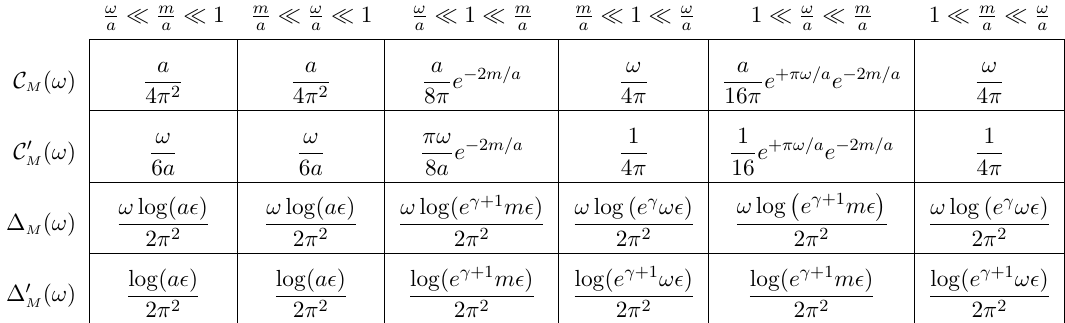
, C 0 , (cid:1) and (cid:1) 0 in various regimes M M M M